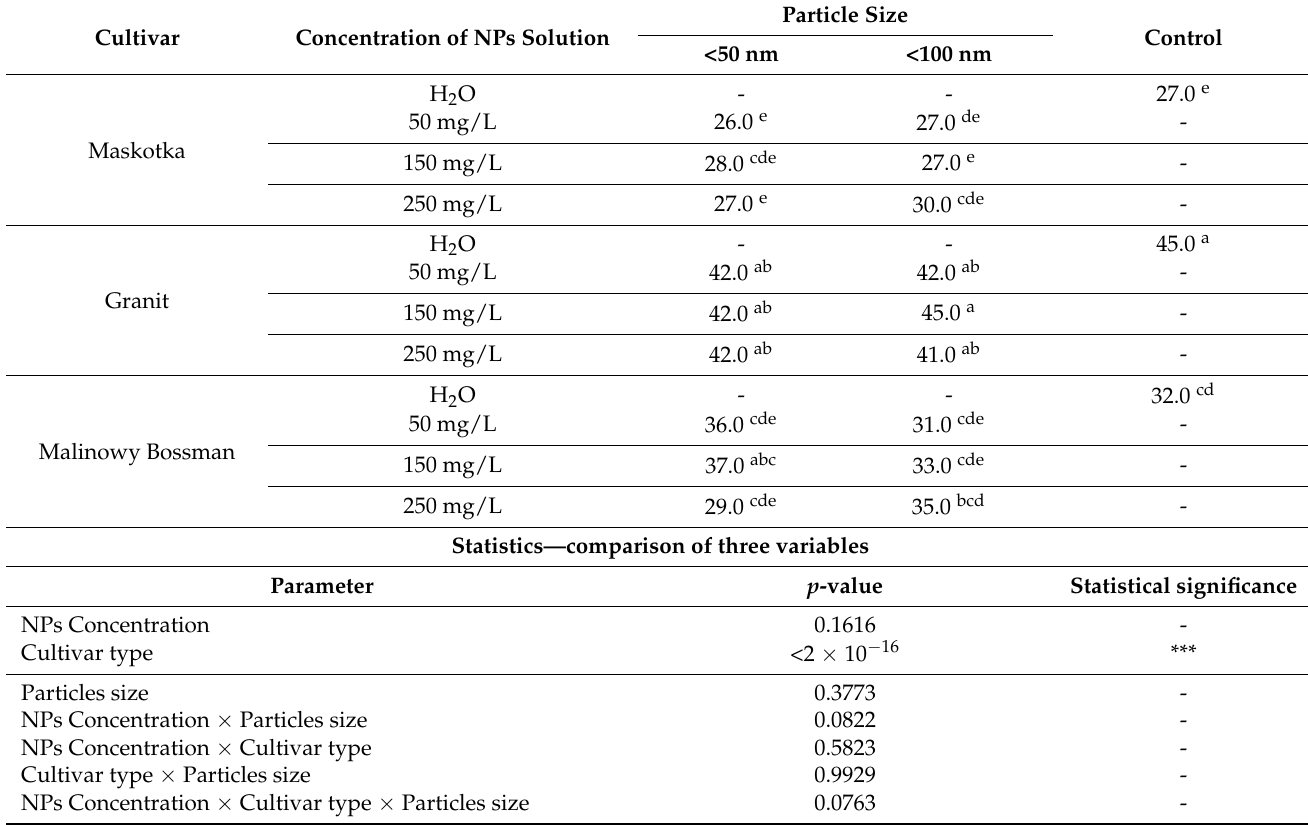
Table A5. The results of dry weight (DW) parameter obtained after treatment and statistic calculations. For this growth parameter, three variables were taken under consideration (NPs suspension, cultivar type, and the size of used NPs). In statistical part of the table, the statistical significance is expressed as “-”, which means that p -value was higher than 0.05 and certain parameters had no significant influence on the results; “***” means that p -value is lower than 0.001. Small letters indicate the significant differences for p -value ≤